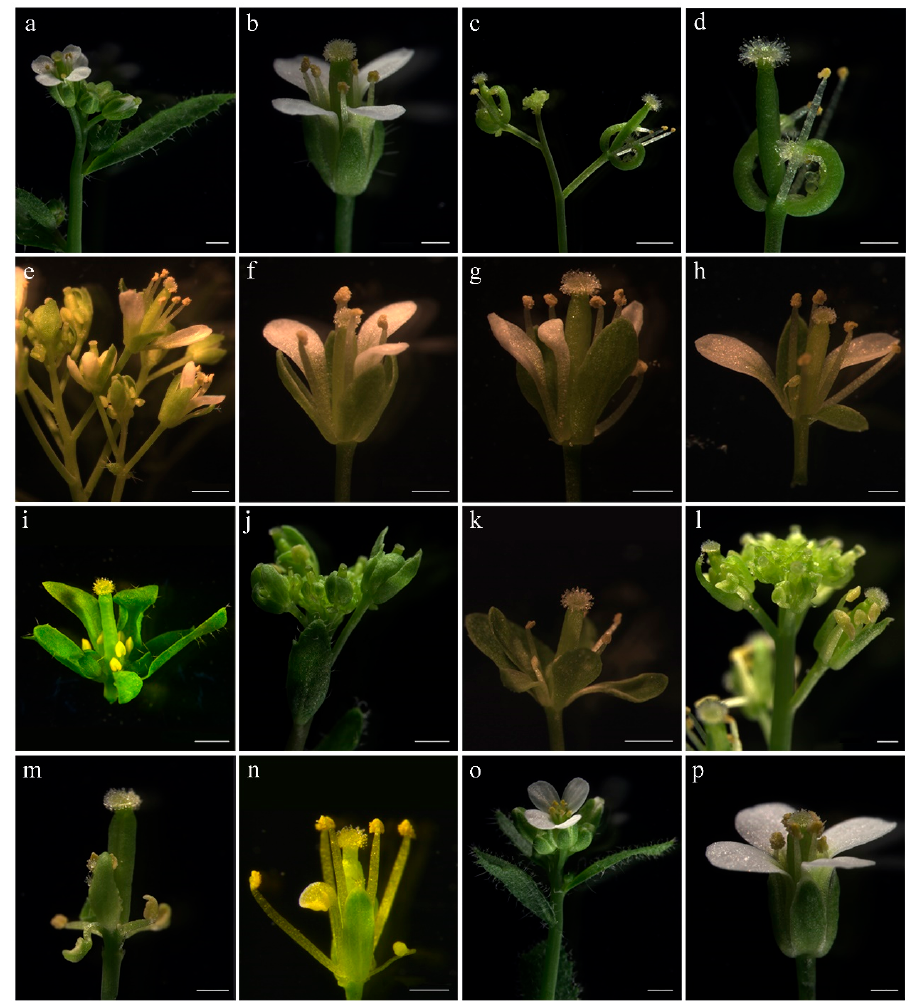
Figure 7. Phenotype comparison of wild-type, homozygous ap1- 10 mutant, 35S::MapaAGL6-1, and 35S::MapaAGL6-2 transgenic Arabidopsis under a homozygous ap1- 10 mutant background, respectively. ( a ) Inflorescence of wild-type Arabidopsis ; ( b ) wild-type Arabidopsis flower with normal four whorls floral organs; ( c ) inflorescence of homozygous ap1- 10 mutant Arabidopsis ; ( d ) flower of homozygous ap1- 10 mutant Arabidopsis with first whorl sepal converted into carpel-like organs bearing ovules and numbers of stamens reduced; ( e – k ) inflorescence or flowers of 35S::MapaAGL6-1 transgenic Arabidopsis under homozygous ap1- 10 mutants with different degrees of rescue: ( e ) inflorescence of 35S::MapaAGL6-1 transgenic Arabidopsis displaying strong complementation phenotypes; ( f ) flowers of a rescued ap1- 10 mutant with four sepals in whorl 1, three petals in whorl 2, and normal stamens and gynoecia in whorl 3 and whorl 4, respectively; ( g ) flowers of a rescued ap1- 10 mutant with two sepals in the first whorl, three petals in the second whorl, and normal stamens and gynoecia in the inner two whorls; ( h ) flowers of a rescued ap1- 10 mutant with two sepals in whorl 1, two petals in whorl 2, six stamens in whorl 3, and normal gynoecia in whorl 4; ( i ) cluster bract-like sepals enclosing normal reproductive structures on an obvious compression floral axis; ( j – k ) inflorescence and flowers of a rescued ap1- 10 mutant without petal whorl; ( l – n ) inflorescence or flowers of 35S::MapaAGL6-2 transgenic Arabidopsis under homozygous ap1- 10 mutants with different degrees of rescue: ( l – m ) inflorescence and flowers of a rescued ap1- 10 mutant with petaloid anthers on the top of the filament; ( n ) flowers of a rescued ap1- 10 mutant with one petal in the second whorl; ( o – p ) inflorescence and flowers of the daughter lines generated from a cross between 35S::MapaAGL6-1 transgenic plants showing strong phenotypes and 35S::MapaAGL6-2 transgenic plants showing phenotypic changes under homozygous ap1 -10 mutant background. Bars: (b,d,f–h,l–n,p) 500 µ m; (a,c,e,i–k,o) 1